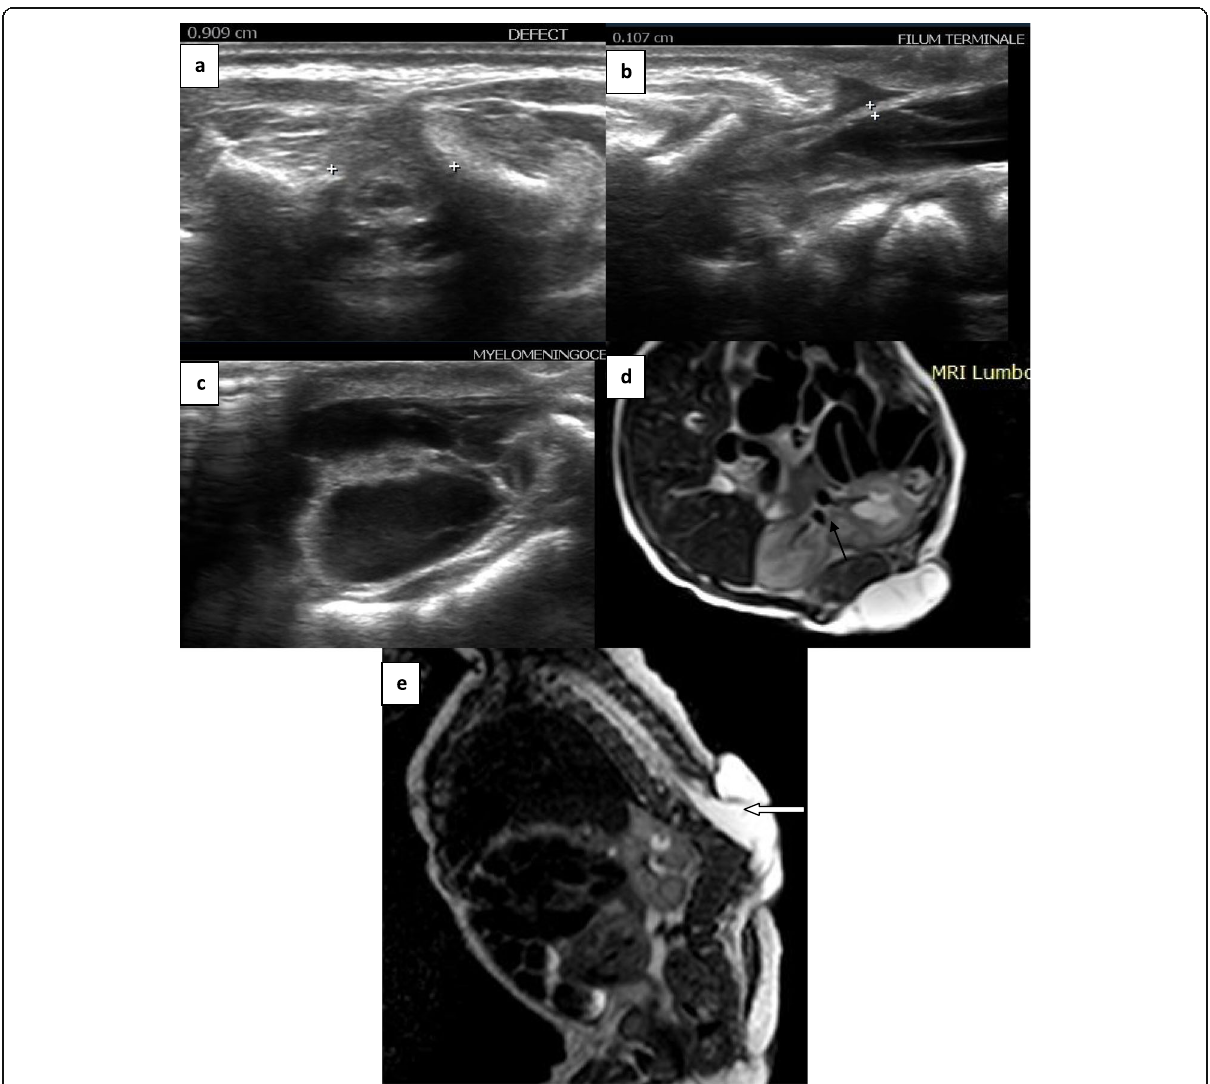
Fig. 1 Six-day-old female neonate presented with lumbar swelling and hydrocephalus, paraplegic with patulous anus, horse shoe kidney and vertebral anomalies. a Transverse USG showed defective spinous process with neural element passing through the defect and neural placode is not in flush with the skin. b Longitudinal USG showed filum terminale passing through the spinal defect. c Longitudinal USG showed cystic lesion showing CSF and nerve roots within (myelomeningocele). d Axial T2W MRI showed associated renal anomaly (horse shoe kidney, black arrow ). e Sagittal T2W MRI showed defective L1 spinous process with all downward posterior components and myelomeningocele passing through the defect ( white arrow ). Final diagnosis is Myelomeningocele with associated vertebral anomalies (segmental spinal dysgenesis), agreement frequency between ultrasound and MRI findings = 94% (segmental spinal dysgenesis was missed by